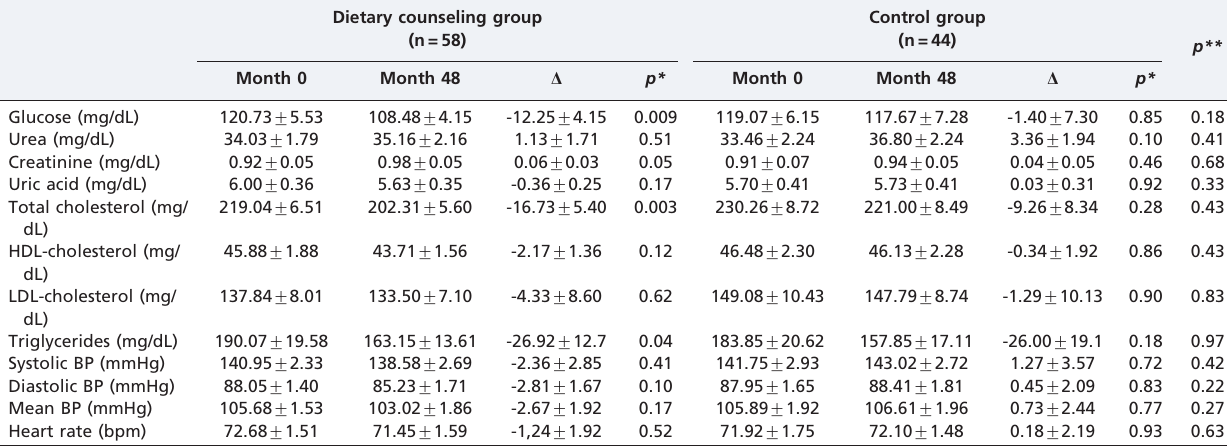
Table 2 - Metabolic variables and blood pressure levels at baseline (Month 0) and at the end of follow-up (Month 48) in the two groups.